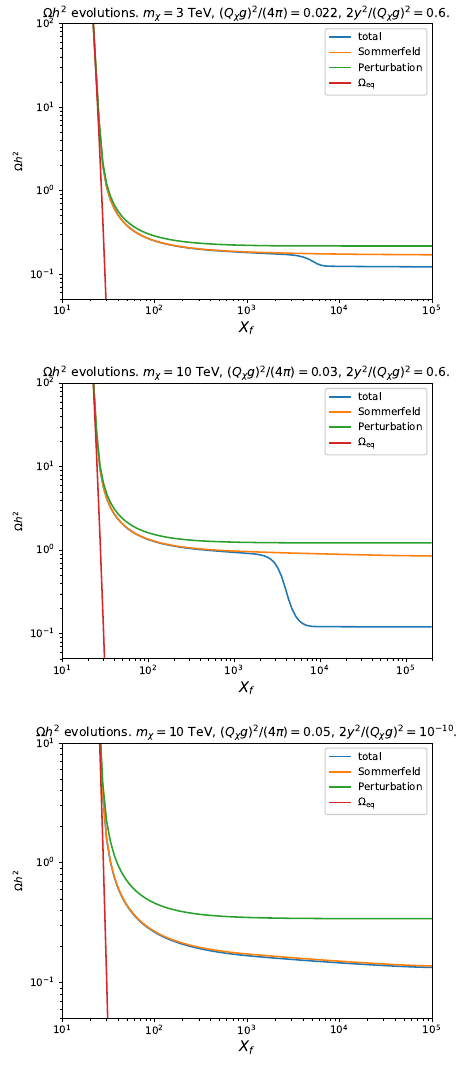
Figure 8 . Evolutions of the (cid:10) h 2 as the tem- perature evolves. The parameters are the same as the corresponding panels in (cid:12)gure